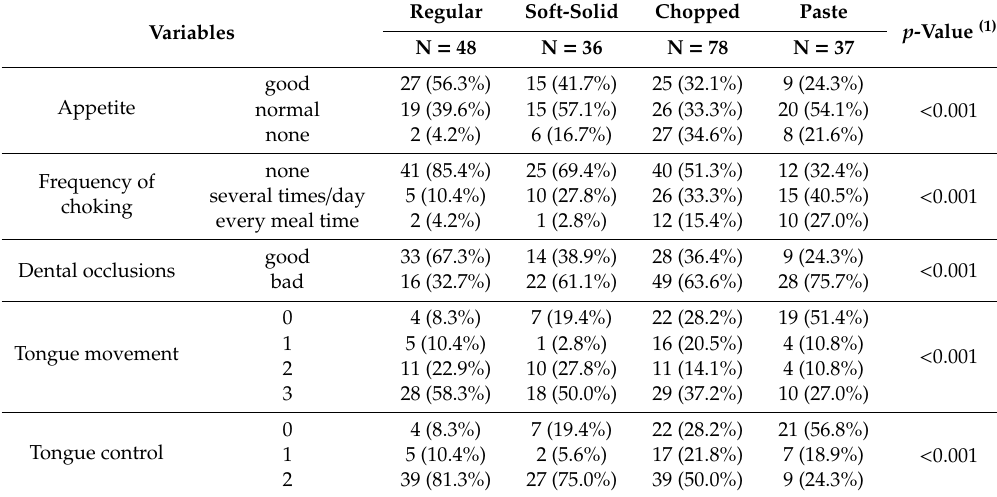
Table 3. Consistency of food substances and appetite and oral